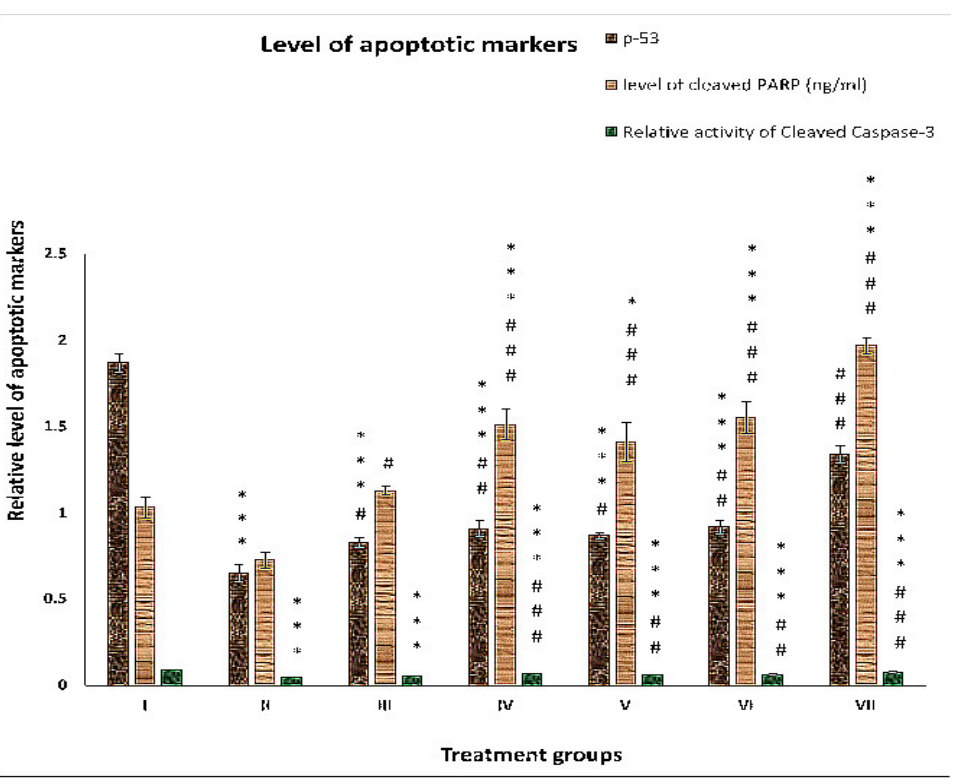
Figure 4. Relative levels of apoptotic markers (p-53, cleaved caspase-3, and cleaved PARP) in the liver samples of the treated groups. The asterisk mark * indicates values significantly different from the control (group I), while # indicates values significantly different from the control positive (group II). All experiments were conducted in triplicate, and the data are presented as the mean ± SEM. p - values were calculated by Student’s t-test, * or # p < 0.05.